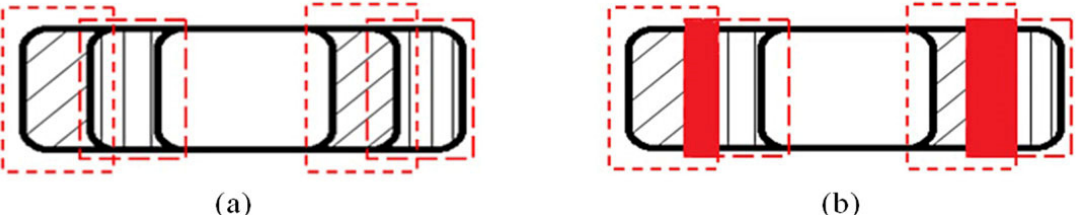
Figure 3. ( a ) Regions (dashed rectangles) of change produced by the motion of target; ( b ) Initial location of the target (red areas).